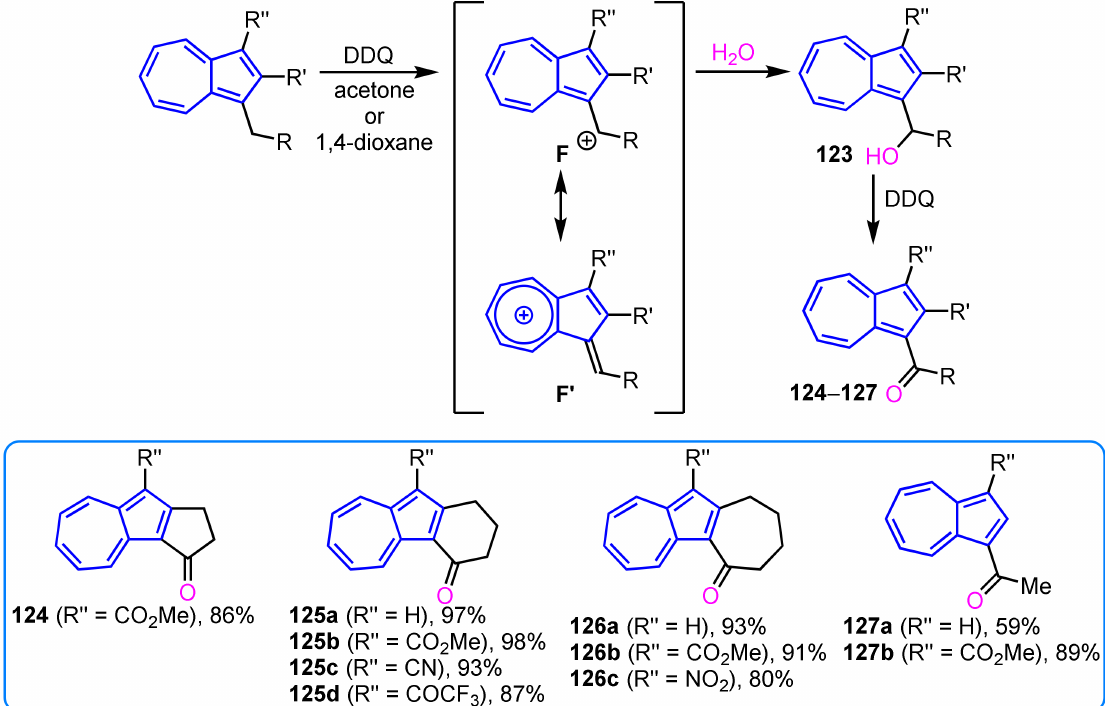
Scheme 31. Oxidation of the α -methylene at the 1-position of the azulene ring with DDQ.